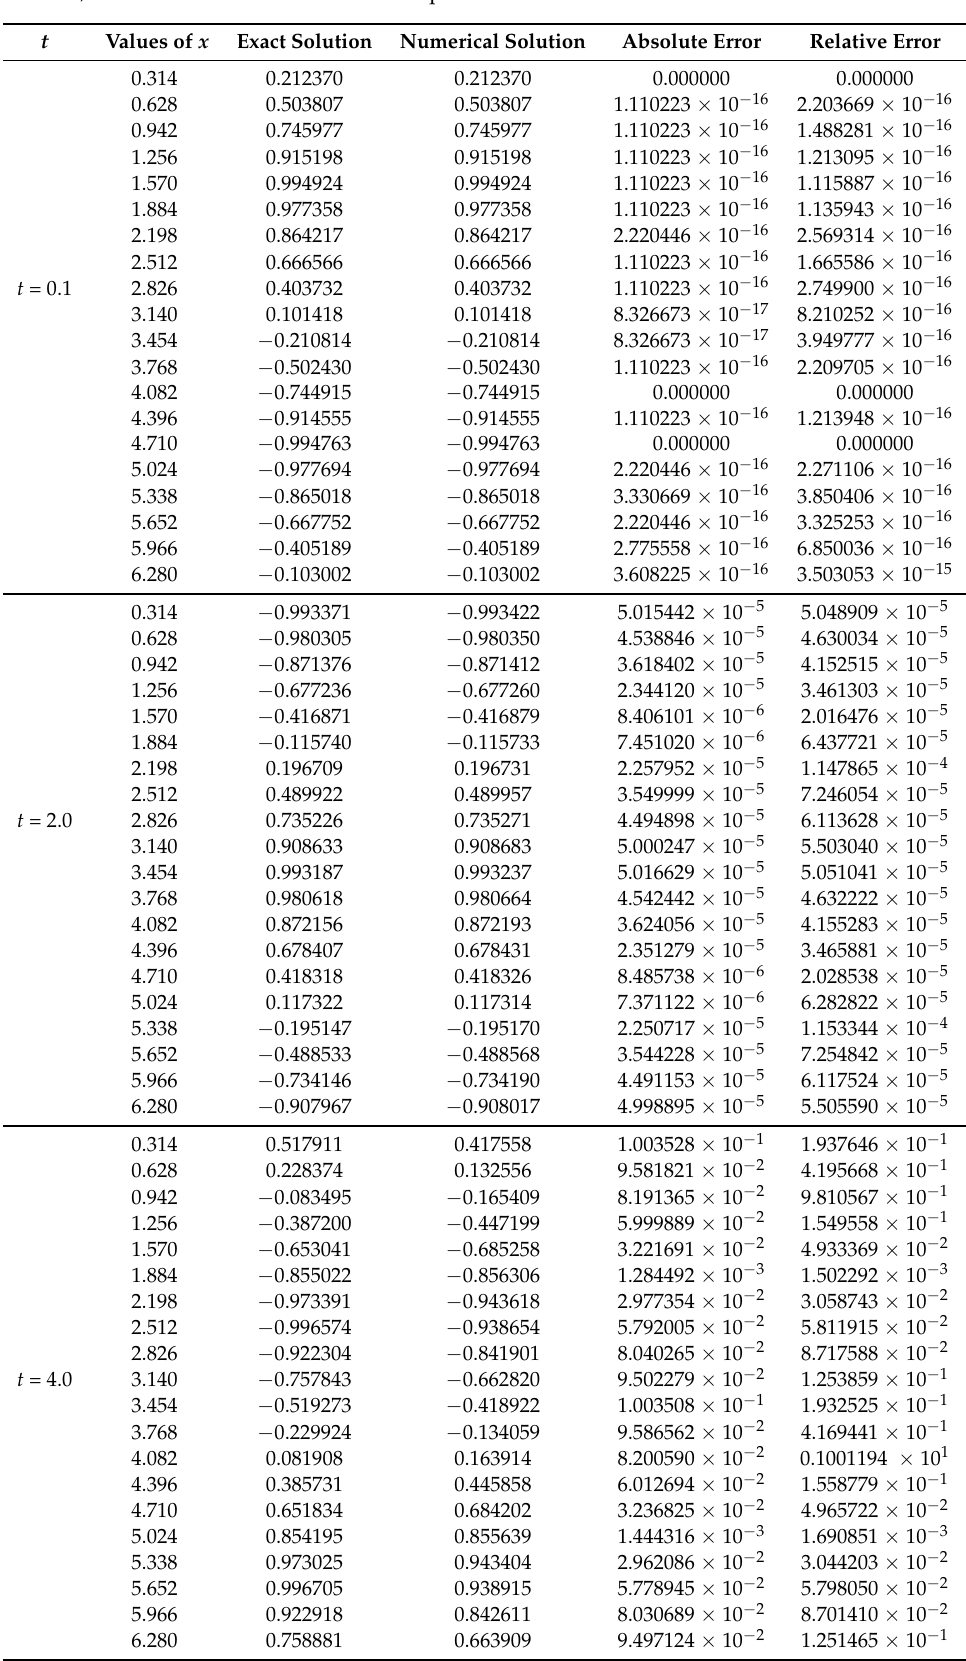
Table 1. Absolute and relative errors at some values of x obtained at times 0.1, 2.0, 4.0 using 10-terms of LADM, HPM and RDTM for numerical experiment